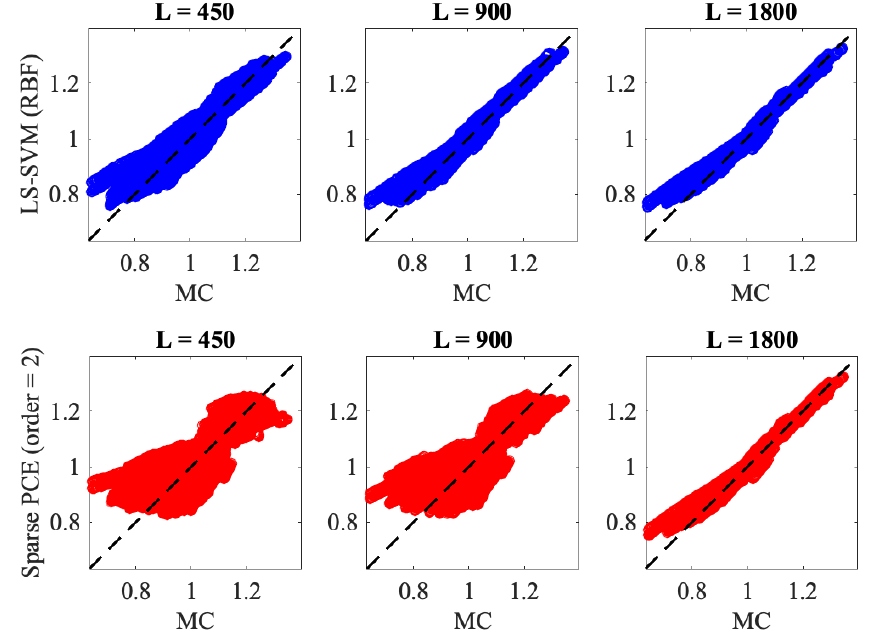
Figure 9. Scatter plots of the network node voltages for Case 2 ( d = 900 uncertain parameters) predicted by LS-SVM regression (top three panels) and sparse PCE (bottom three panels) surrogate models trained with an increasing number of samples, versus the results of MC